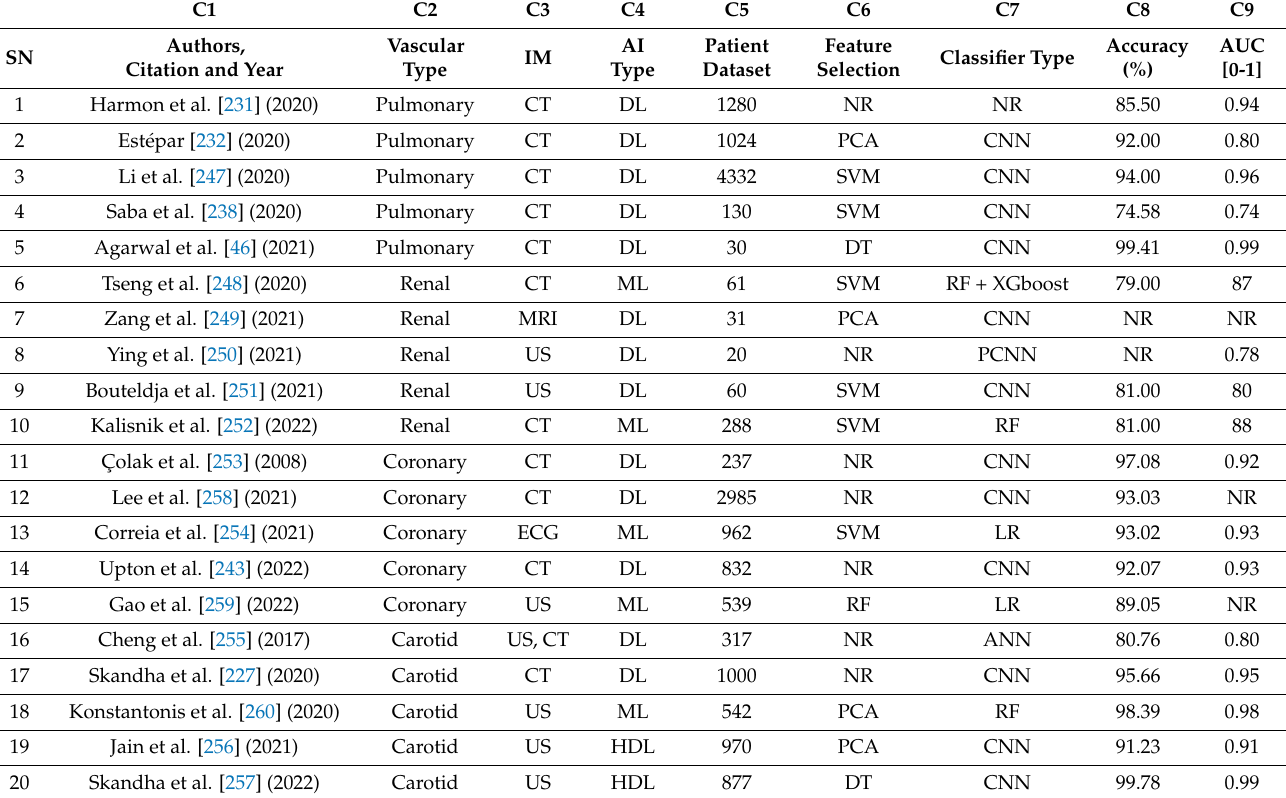
Table 6. Benchmarking scheme for four types of COVID-19 vascular